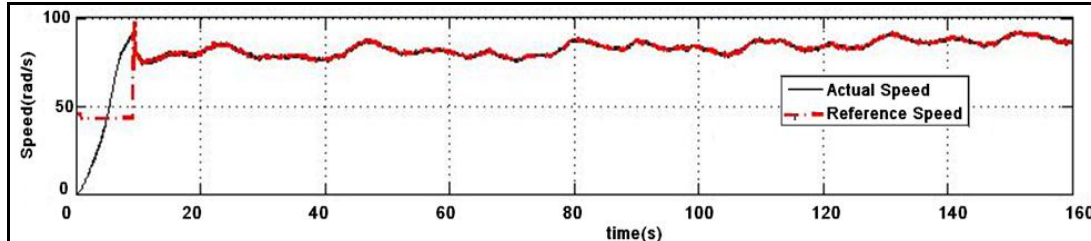
Figure 11. Speed tracking and load voltage under the adaptive SMC system for variable loads. Energies 2018 , 11 , x